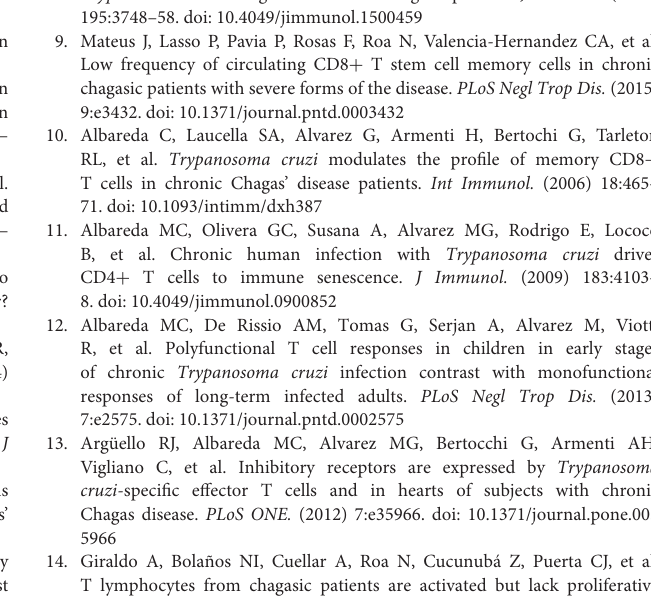
Supplementary Figure 1 | Gating strategy for 3-color flow cytometry with a sample from a representative CCC donor. Mononuclear cells were defined according to FSC vs. SSC parameters and gated on the singlets. HLA-DR + population gate was determined based on the isotype control. On this population, it was defined the percentage of total monocytes (CD14 + CD16 + cells) and monocyte subsets according to CD14 and CD16 expression as follows: CD14 ++ CD16 − (classical), CD14 ++ CD16 + (intermediate) and CD14 + CD16 ++ (non-classical). Supplementary Figure 2 | Mean fluorescence intensity (MFI) for HLA-DR expression in monocyte subsets from IND, CCC, HTCC, NCC and HI. Significant differences determined by Kruskal-Wallis test followed by Dunn’s post hoc test are shown as follows: ∗ p < 0.05, ∗∗ p < 0.01, ∗∗∗ p < 0.001, ∗∗∗∗ p < 0.0001. Supplementary Figure 3 | Monocyte subsets and left ventricular ejection fraction (LVEF) variations associated with the time of heart transplantation and reactivation of T. cruzi infection. As shown for CCC16 and CCC18 patients, the percentages of classical monocytes increased and the percentage of intermediate monocytes diminished after heart transplantation, while IL-12p40 blood levels augmented in both patients. In the case of CCC21 patient, it was observed similar monocyte subsets changes upon antiparasitic treatment for parasite